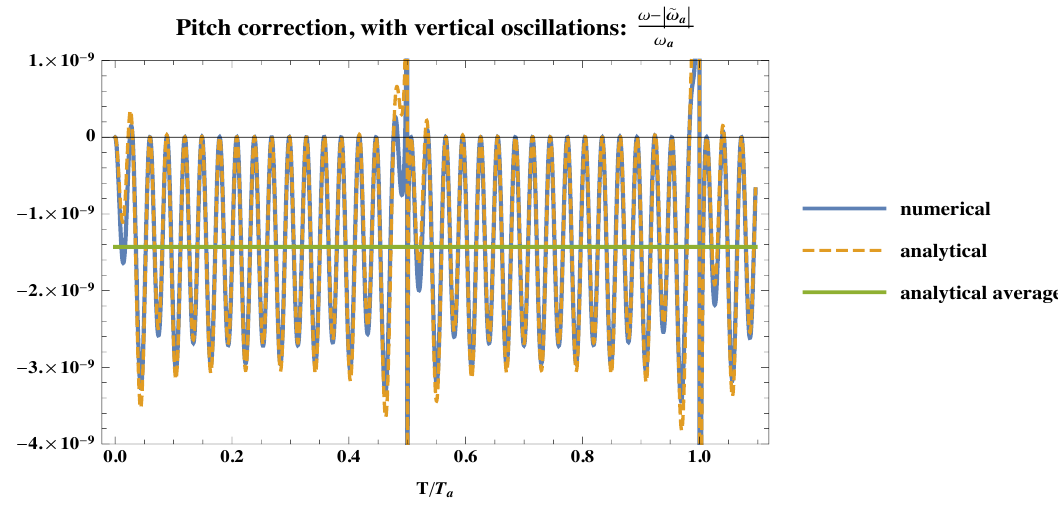
Figure 3 . We have solved numerically the equations of motion and then evaluated " # 1 = 2 ( ^ B (cid:1) (cid:6))(^(cid:6) (cid:1) ^ B ) ! (cid:17) ! a 1 (cid:0) ; (^(cid:6) (cid:1) v ) from eq. (4.40) and j ~ ! a j (which contains the traditional \pitch" correction) from eq. (4.42), on the solution. We also show the very good agreeement with our analytical result of eq. (6.18). Taking a time average over the fast oscillations we get precisely the subleading correction (cid:14)! SL of eq. (6.14), which also coincides with eq. (6.19) (green line). Here T a (cid:17) 2 (cid:25)=! a and we used (cid:6) z = 0